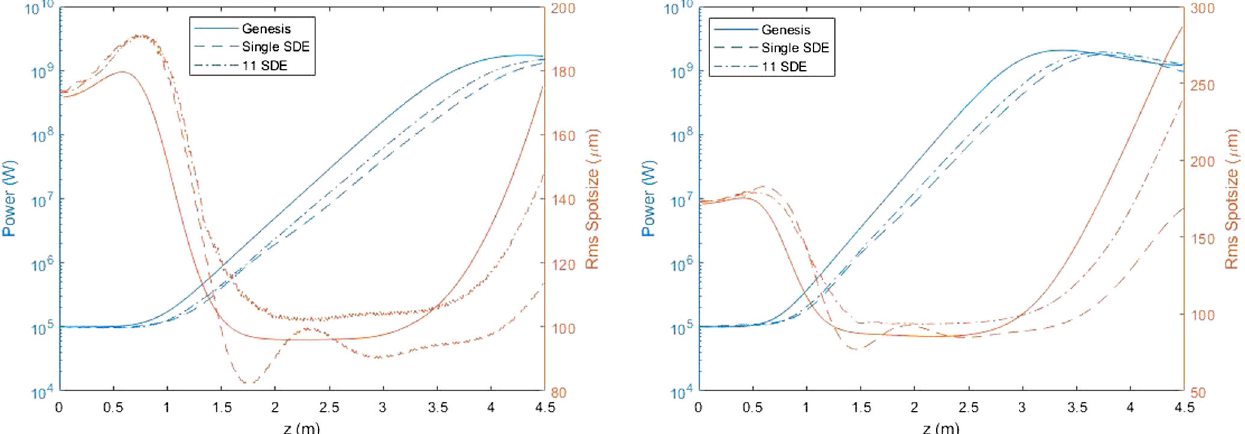
FIG. 3. A comparison of GPT - FEL running with single frequency SDE versus GENESIS 1.3 . (a) The Ming Xie predicted gain length for the planar amplifier is 0.287 m. The simulated gain length for a single SDE spatial mode is 16% larger. Running with 11 SDE spatial modes reduces the difference to 5.9%. (b) The predicted gain length for the helical amplifier is 0.224 m. Simulating 1 and 11 SDE modes leads to differences of 15% and 8.2%, respectively.